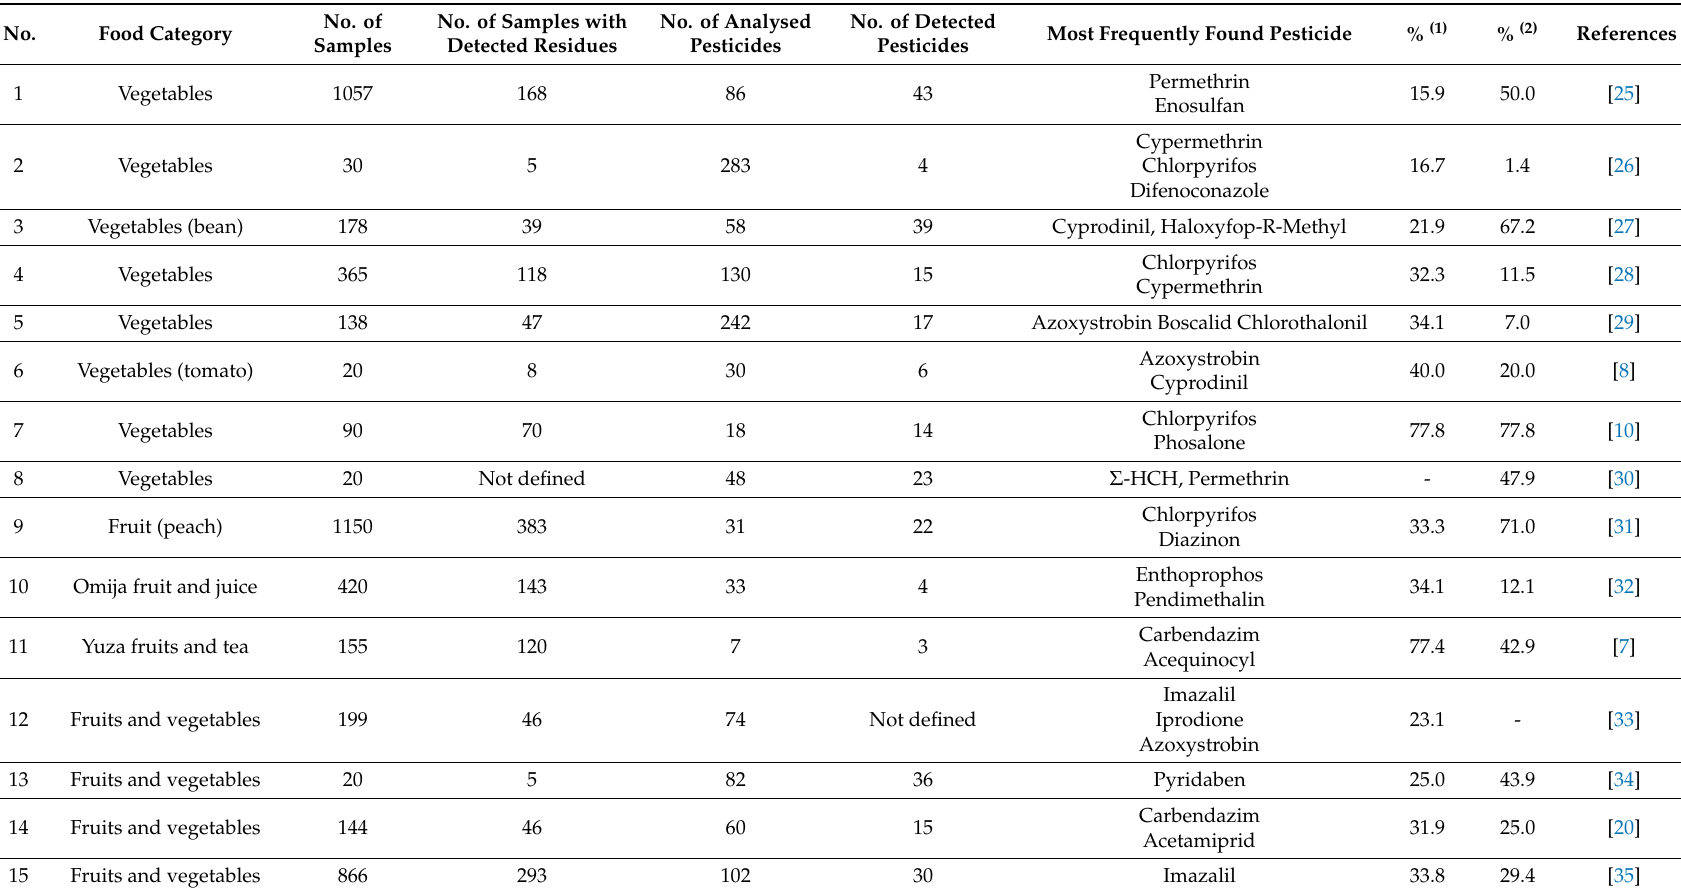
Table 3. Summary of the most frequently detected pesticides in di ff erent food samples reported in the